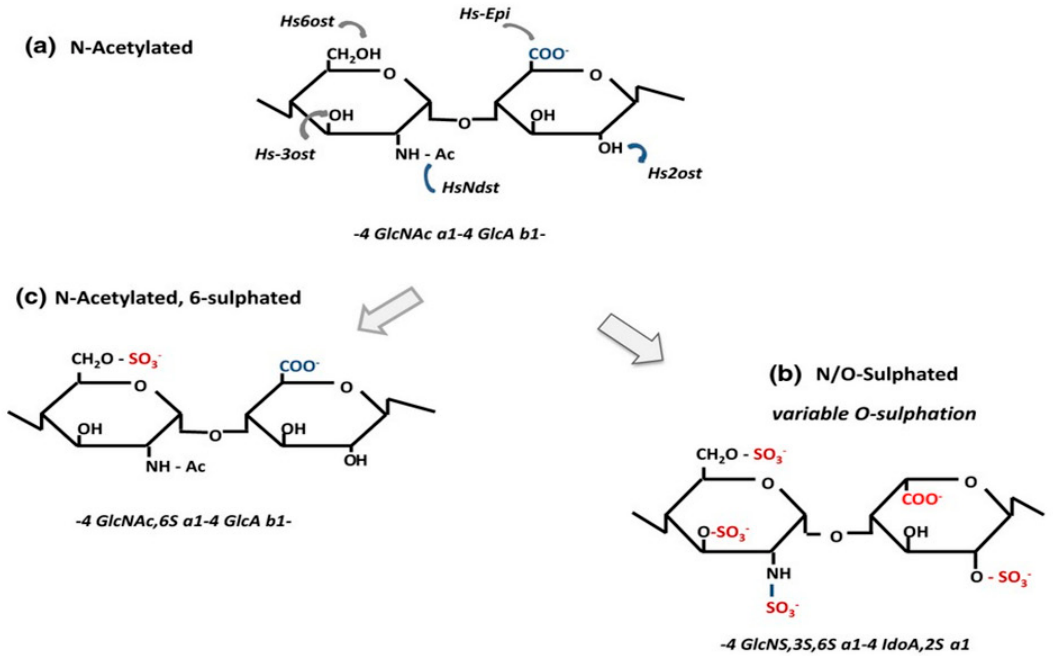
Figure 1. Enzymatic Modifications in the Biosynthesis of Heparin and Heparan Sulphate. Heparin and heparan sulphate (HS) are first synthesised as non-sulphated polymers (GlcNAc-GlcA repeat units) that are modified to different degrees by a combination of N - and O -sulphation and epimerisation. The initial modification step carried out by the Ndst enzymes is the conversion of GlcNAc to GlcNS; in heparin, about 90% of GlcNAc residues are converted to the N -sulphated derivative whereas in HS the level of conversion is normally in the range of 40 to 50%. In a mature heparin polymer, the main disaccharide is a trisulphated unit (GlcNS6S-IdoA2S), whereas in HS the sulphated and epimerised disaccharides occur in clusters and with a low frequency (normally below 10%) of trisulphated units. In both polymers, 3- O -sulphation, though rare, is a key functional group in the high-affinity antithrombin binding sequence, but can also be found in non-anticoagulant sequences. Key to enzymes: Hs Ndst : N -deacetylase/ N -sulphotransferase, Hs epi : C5-epimerase , Hs2ost : 2- O -sulphotransferase, Hs6ost